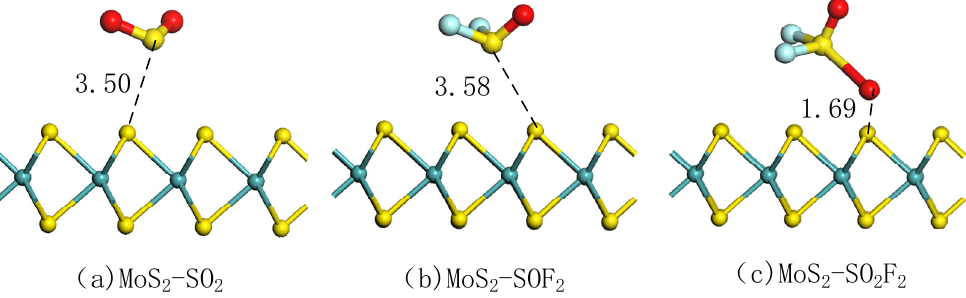
Figure 5. Adsorption structures of MoS 2 for ( a ) SO 2 ( b ) SOF 2 ( c ) SO 2 F 2 .